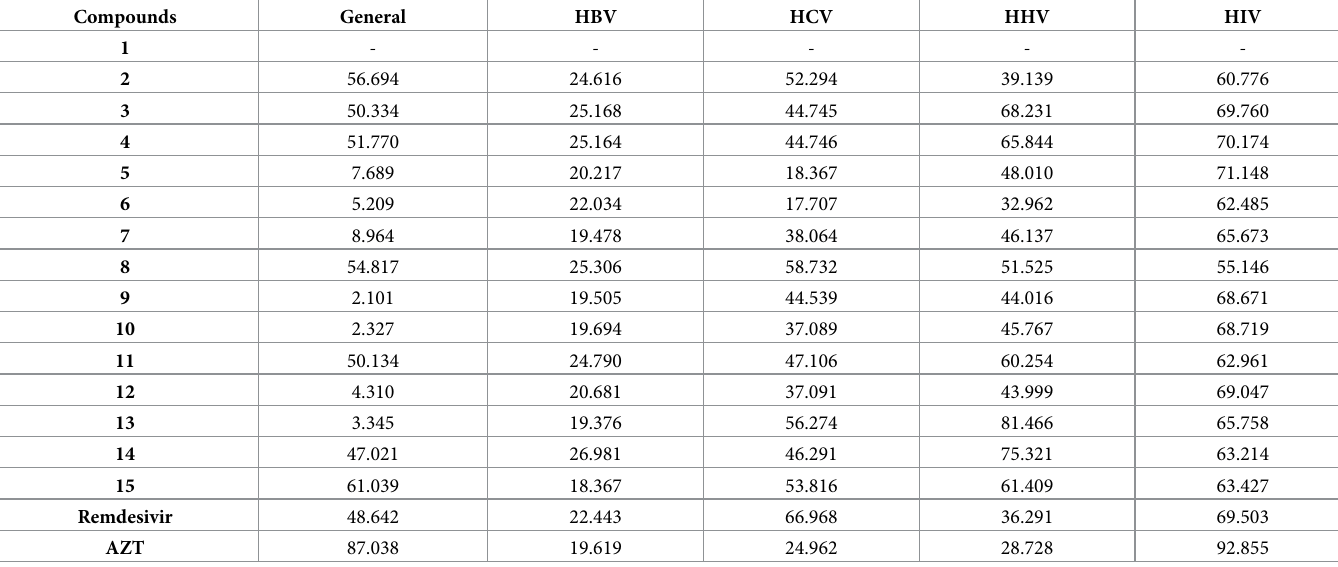
Table 1. Predicted antiviral activities (% inhibition) of cytidine derivatives 2–15, remdesivir, and AZT.